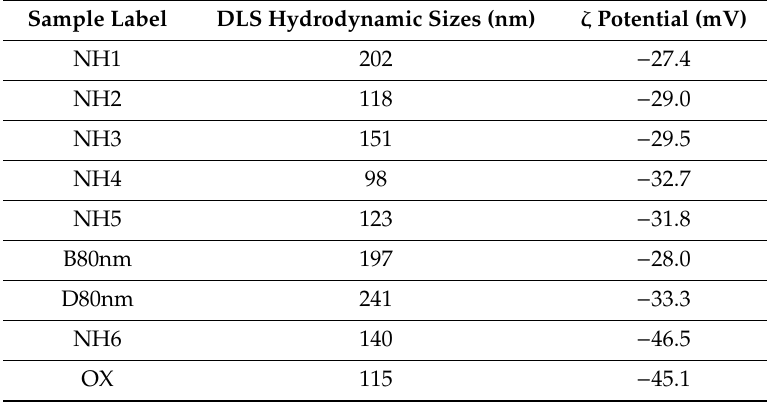
Table 2. Dimensions of aggregates and zeta potential of samples.